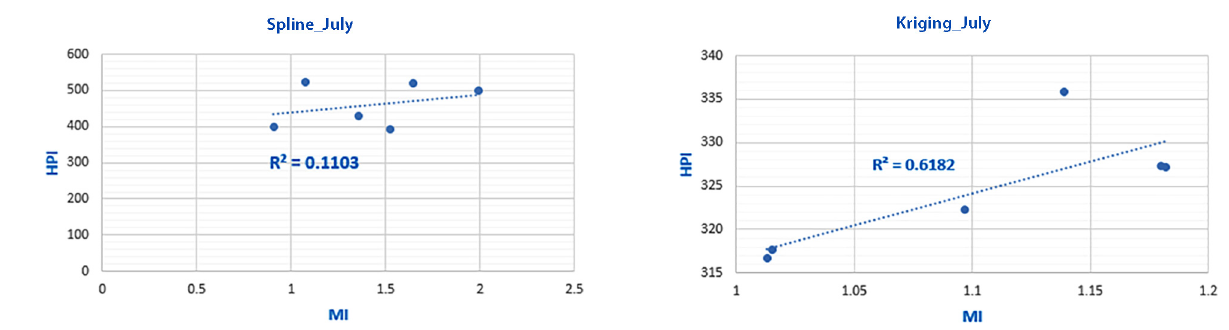
Figure 10. Correlation analysis of July, 2018 (Spline and